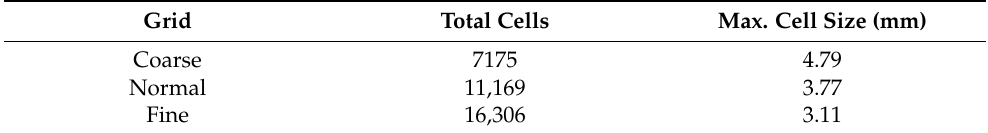
Table 5. Configuration of the grids.